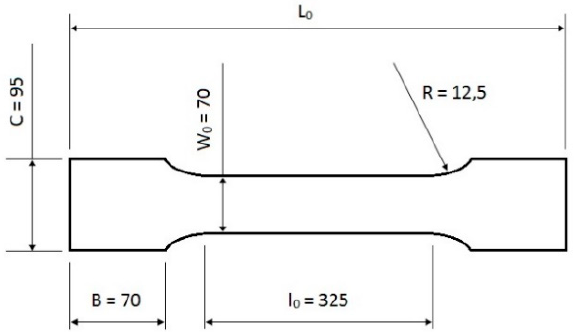
Figure 1. Standard sample in accordance with ISO 6892-1:2009 [mm].